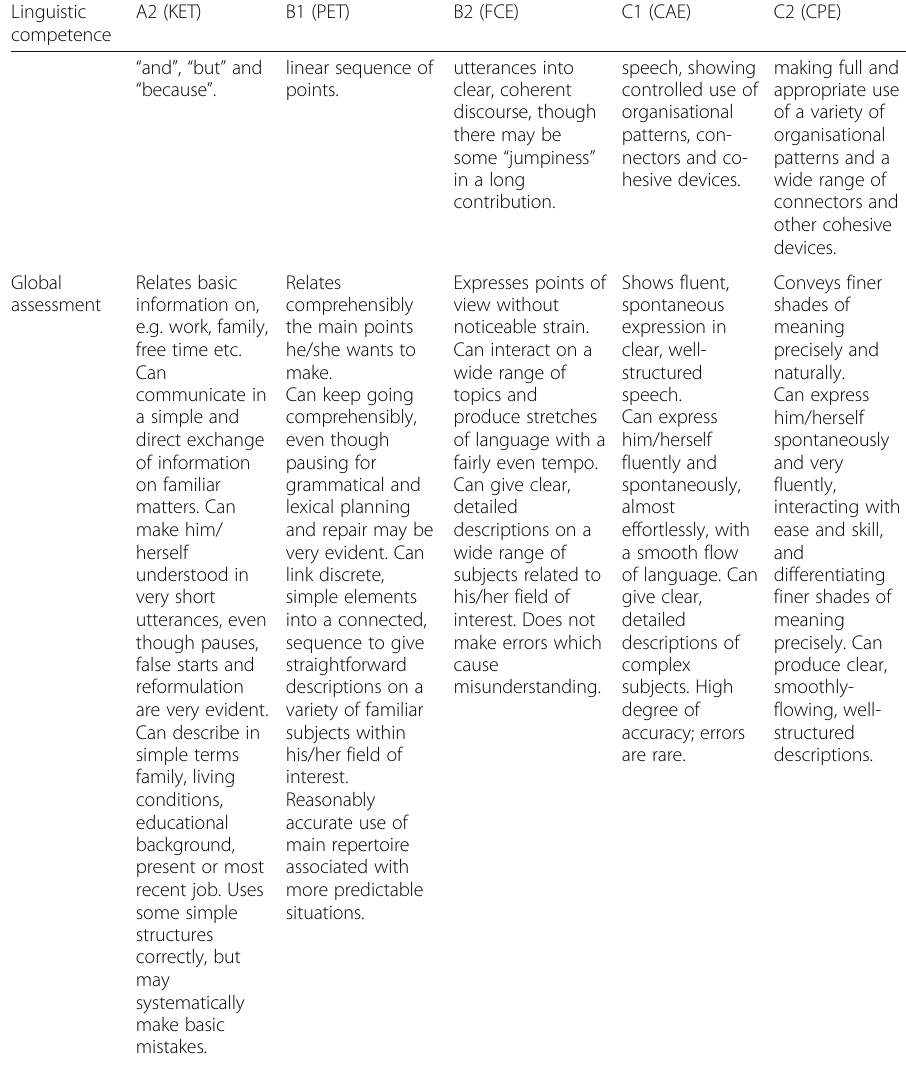
Table 10 CEFR descriptor scales for linguistic competence (Council of Europe 2001, pp. 28, 29, 117) (Continued) Linguistic A2 (KET) B1 (PET) B2 (FCE) C1 (CAE) C2 (CPE) competence “ and ” , “ but ” and linear sequence of “ because ” .